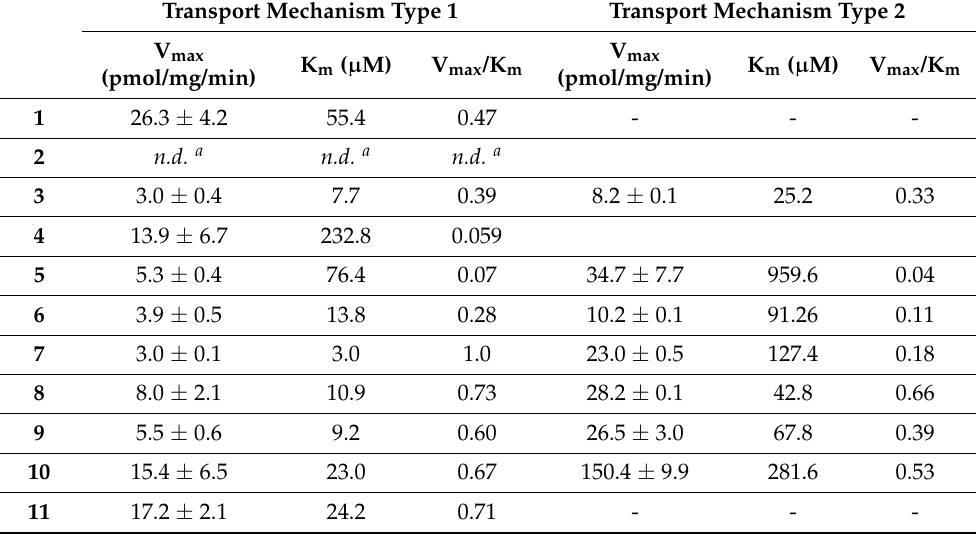
Table 1. Michaelis-Menten Kinetic Parameters Calculated from Eadie-Hofstee Plot Analysis for Transporter-Mediated Cellular Uptake of Compounds 1 – 11